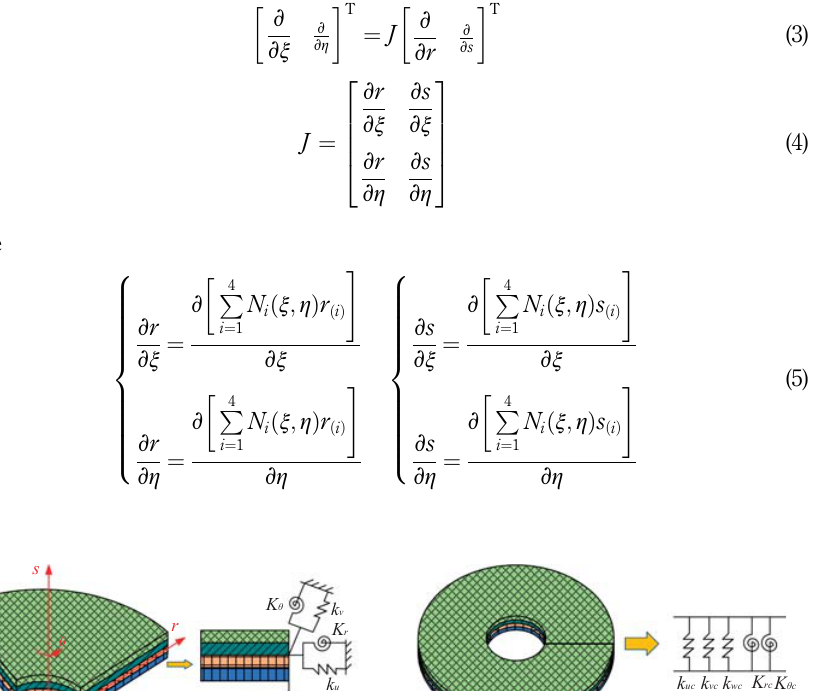
Figure 3. The boundary springs and coupled springs of the rotary composite laminated plate